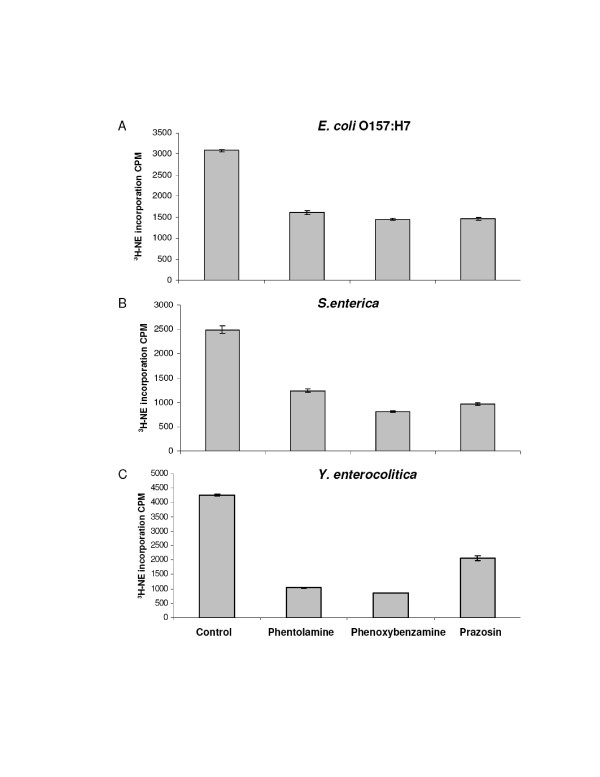
α-Adrenergic antagonist inhibition of bacterial uptake of NE. Washed exponential cultures of E. coli O157:H7, S. enterica, or Y. enterocolitica were added at a cell density of around 2 × 108 CFU/ml to DMEM containing 50 μM NE plus 5 × 105 cpm/ml of 3H-NE and the following: no additions (Control), or 200 μM phentolamine, phenoxybenzamine or prazosin. Cultures were incubated statically for 6 hrs at 37°C in a 5% CO2 humidified incubator, and analysed for growth and 3H-NE uptake as described in Materials and Methods. 3H-NE uptake assays were performed in duplicate on at least two occasions; variation within individual assay sets was 5% or less, and between experiments no more than 10%. Antagonist supplemented cultures showed statistically significant decreases in uptake of 3H-NE (P < 0.001) as compared with the Control.